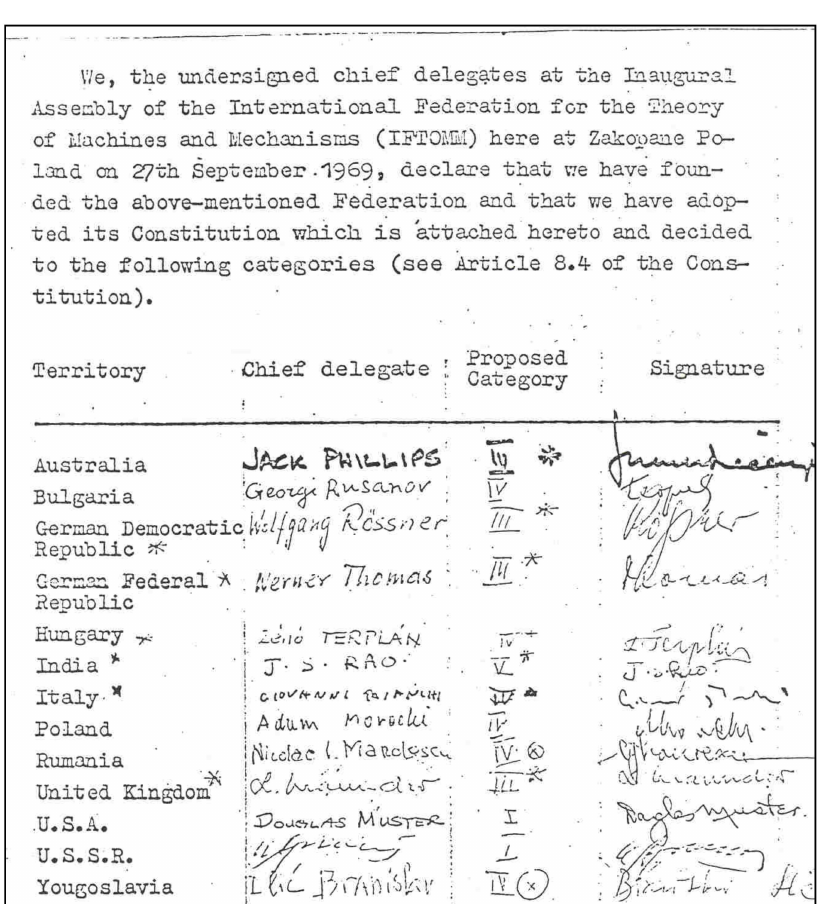
Figure 2. The founding act of